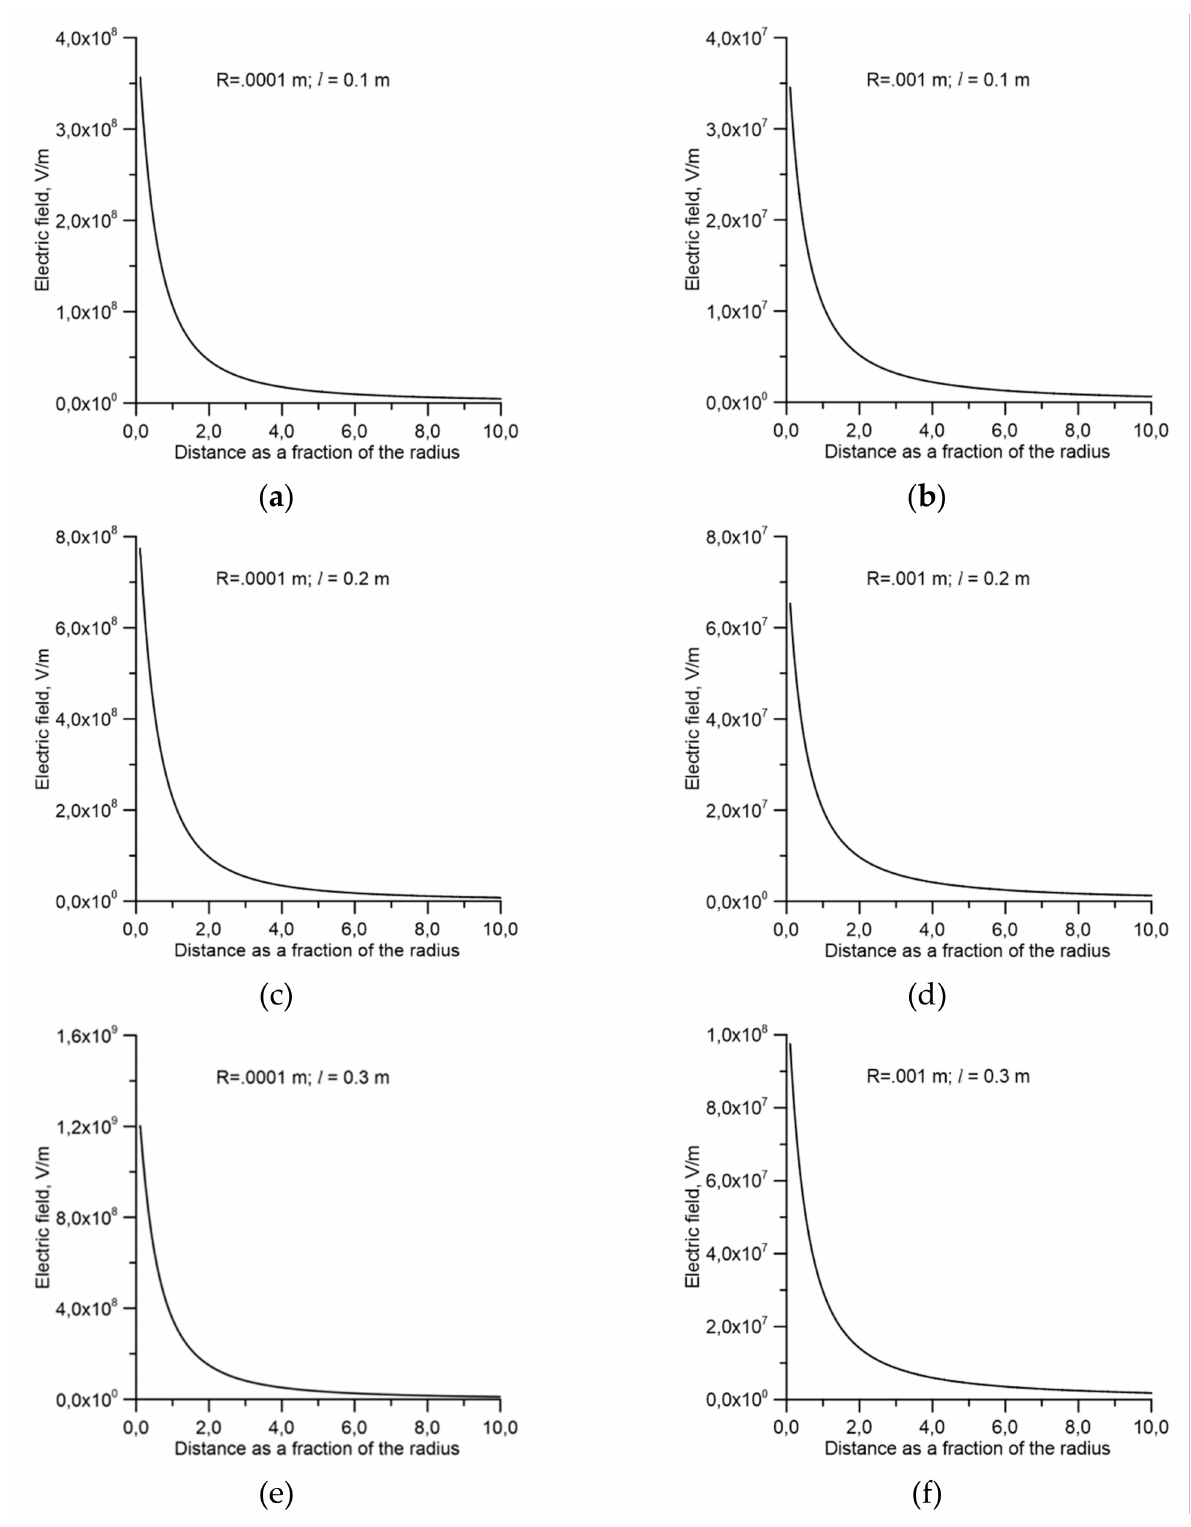
Figure 3. The electric field that is created ahead of the ionization wave for different values of l , the length of the ionization wave, and its radius R . Note that the distance ahead of the ionization wave is given as a fraction of the radius R . In the calculations, it is assumed that the background electric field that polarizes the ionization wave is 10 6 V/m. Results are presented for different lengths of the ionization wave and the radius of the channel. ( a ) R = 0.0001 m, l = 0.1 m; ( b ) R = 0.001 m, l = 0.1 m; ( c ) R = 0.0001 m, l = 0.2 m; ( d ) R = 0.001 m, l = 0.2 m; ( e ) R = 0.0001 m, l = 0.3 m and ( f ) R = 0.001 m, l = 0.3